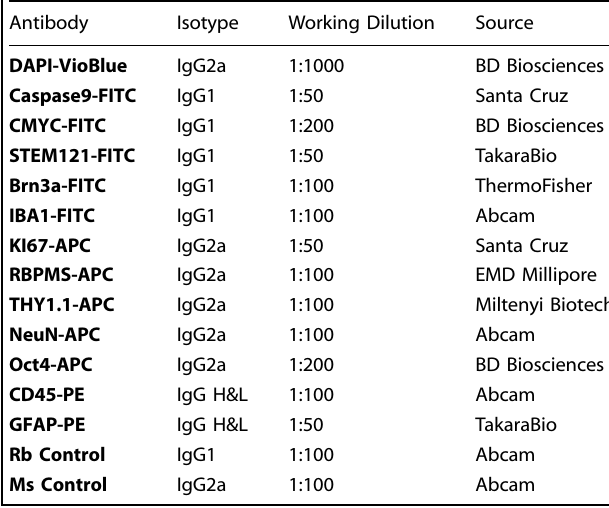
Table 2. Name, isotype, working dilution and source of antibodies used for fl ow cytometry and